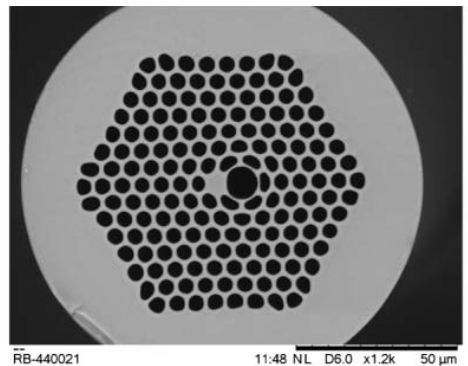
Figure 42. Cross-section of the proposed gold layer containing D-shaped PCF refractive index sensing probe which worked based on SPR theory (Reproduced from [33], with the permission of Springer publishing).